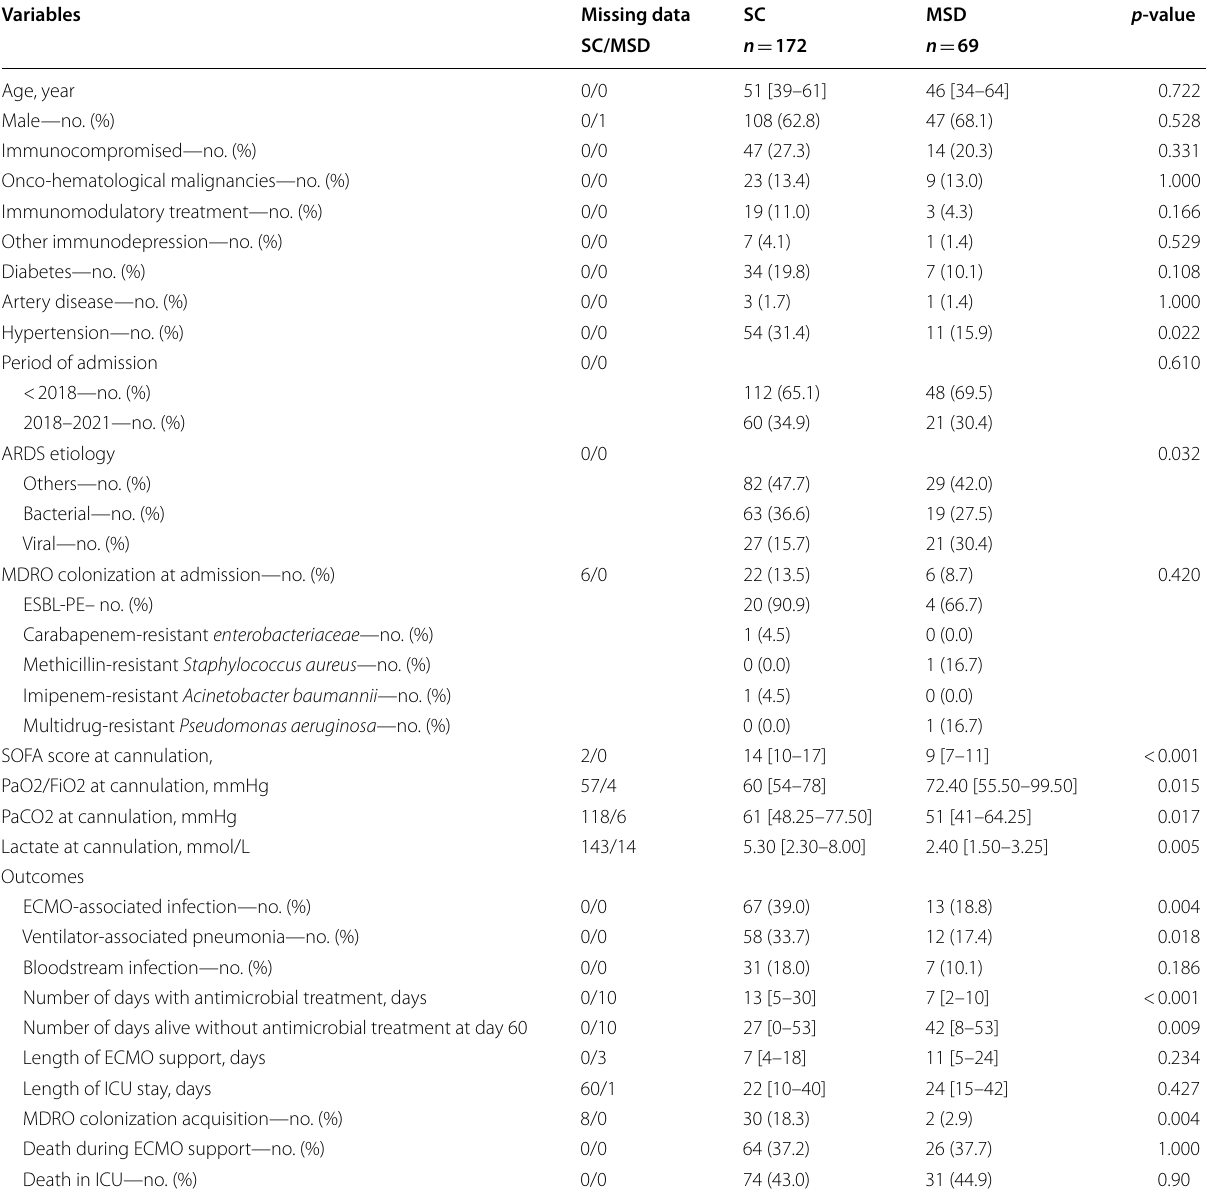
Table 1 Baseline characteristics and outcomes of study